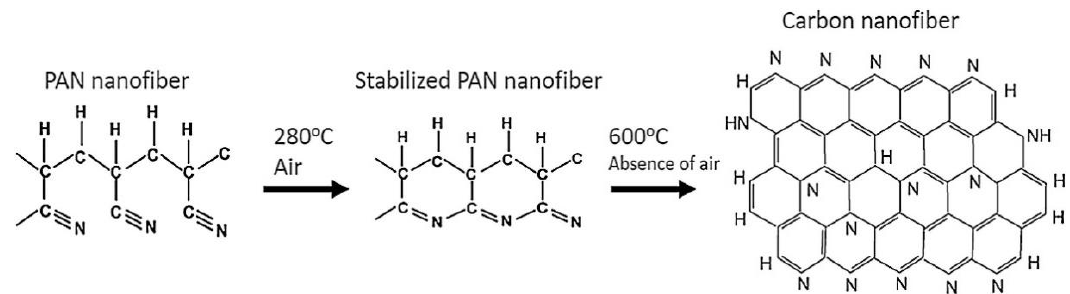
Figure 3. The effect of thermal treatment in PAN structure change (proposed by Ibupoto et al.) Reprinted with permission from [105]. Copyright (2018) by Elsevier Publishing.